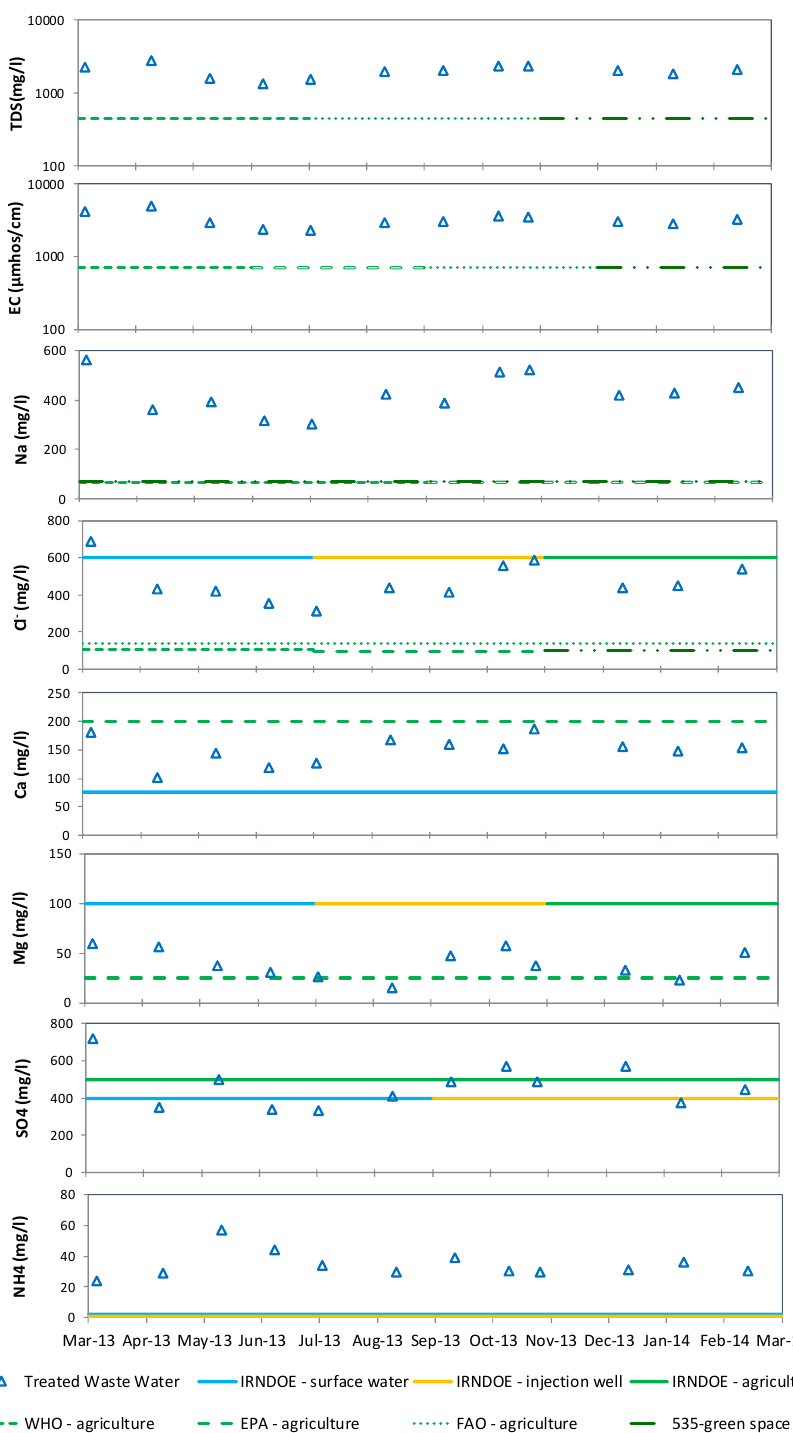
Fig. 2: Concentrations of TDS, EC, Na, Cr, Ca, Mg, SO 4 and NH 4 parameters in the collected samples compared to